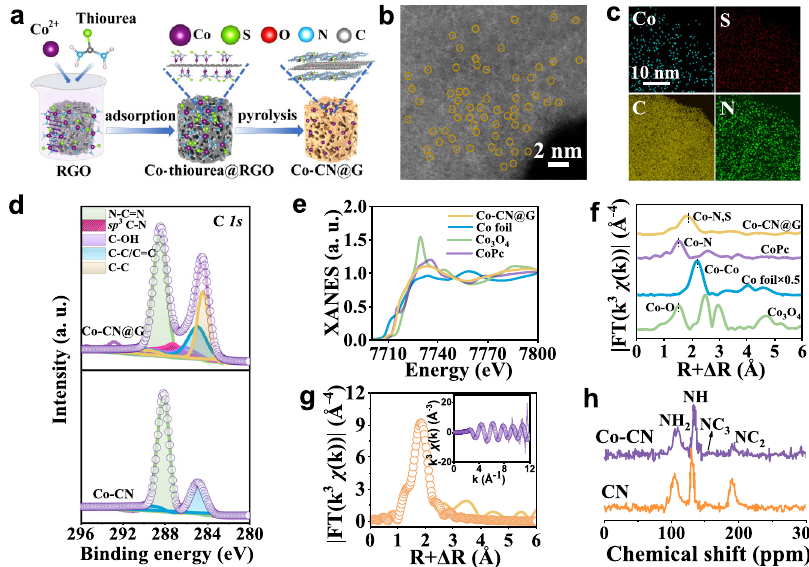
Fig. 1 | Preparation, characterizations, and analysis of Co – CN@G. a Schematic illustration of the synthesis of Co – CN@G. b HADDF-STEM image. The bright spots of Co atoms are marked with yellow circles. c EDS mapping of Co – CN@G. d High- resolution C 1s XPS spectra of Co – CN@G and Co – CN. e XANES spectra at the